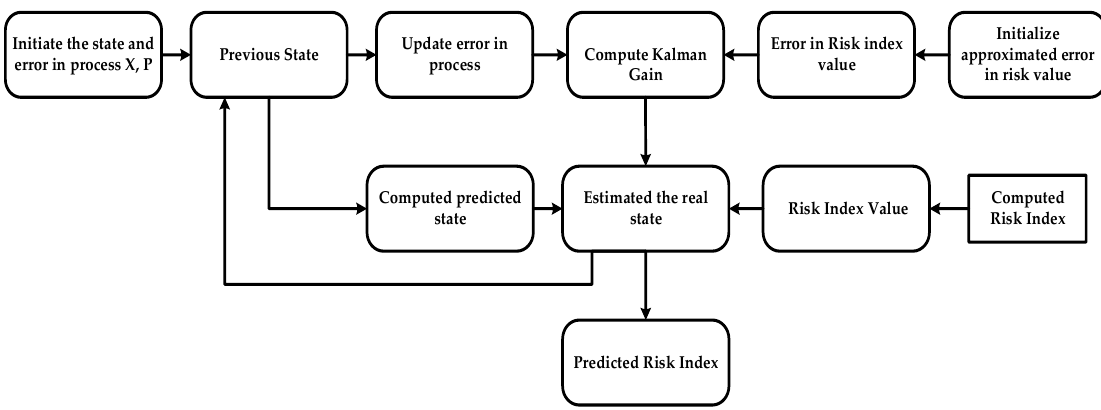
Figure 6. Kalman filter model for underground risk index prediction.